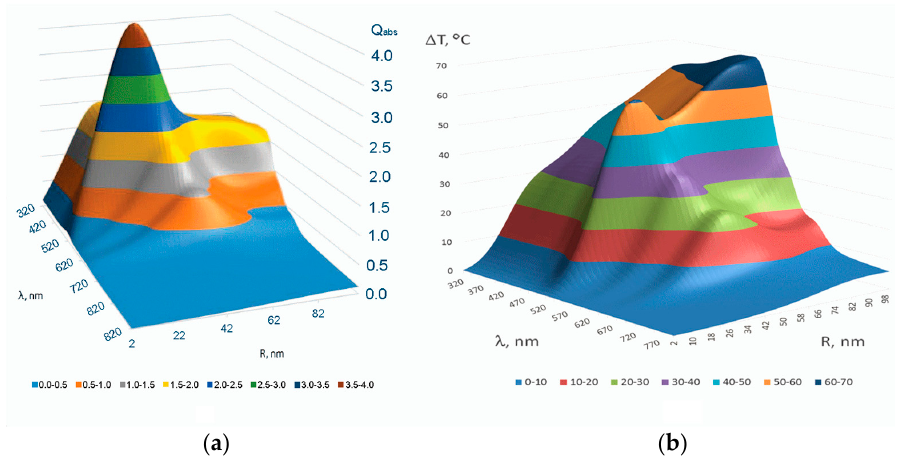
Figure 4. Distribution of the efficiency of absorption of the AuNP ( a ) [52] and of the temperature increment Δ T ( b ) on the surface of the AuNP versus wavelength λ and nanoparticle radius R ; ( b ) is from [47] with permission of the Publisher.